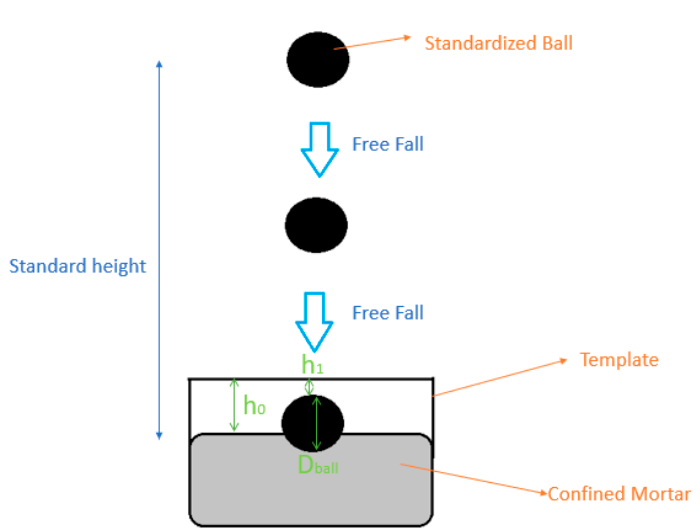
Figure 3. Exemplification of the rheology test by dropping-ball.